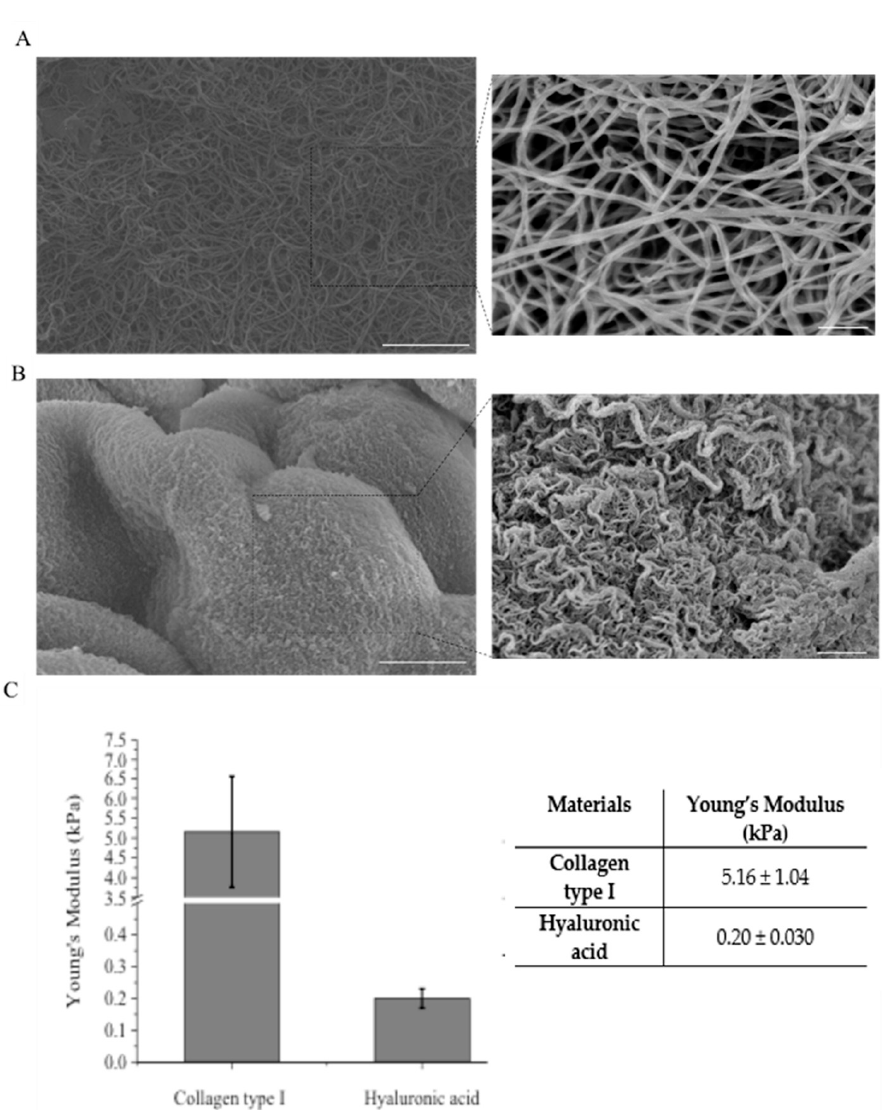
Figure 4. Mechanical characterization of natural hydrogels. ( A , B ) SEM micrographs of COL and HA, respectively, showing very distinct morphologies. Magnified images are presented on the right. COL presents a fibrous structure with a variable porosity. HA presents a complex dense structure. ( C ) Young’s modulus of COL and HA hydrogels. Scale bar = 5 µ m and 500 nm for the low and high magnification images, respectively. Statistical analysis was determined using t -test multiple comparison with a confidence level of 95% ( p < 0.05). GraphPad was